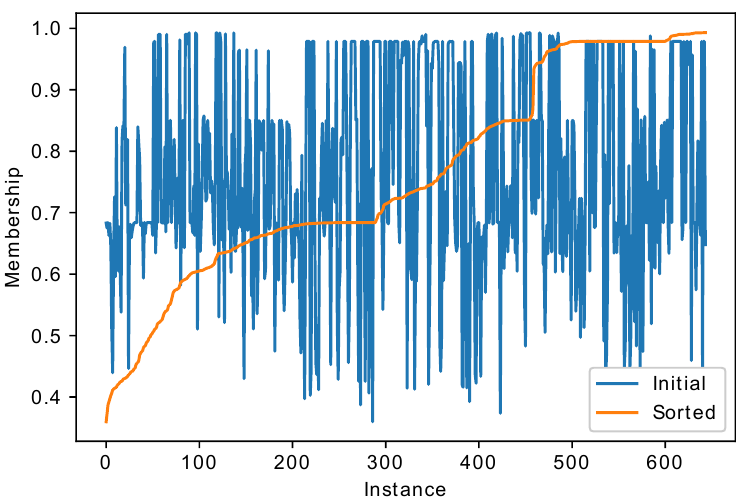
Figure 6. Neural net outputs returned from softmax layer for the true class, satimage dataset, test